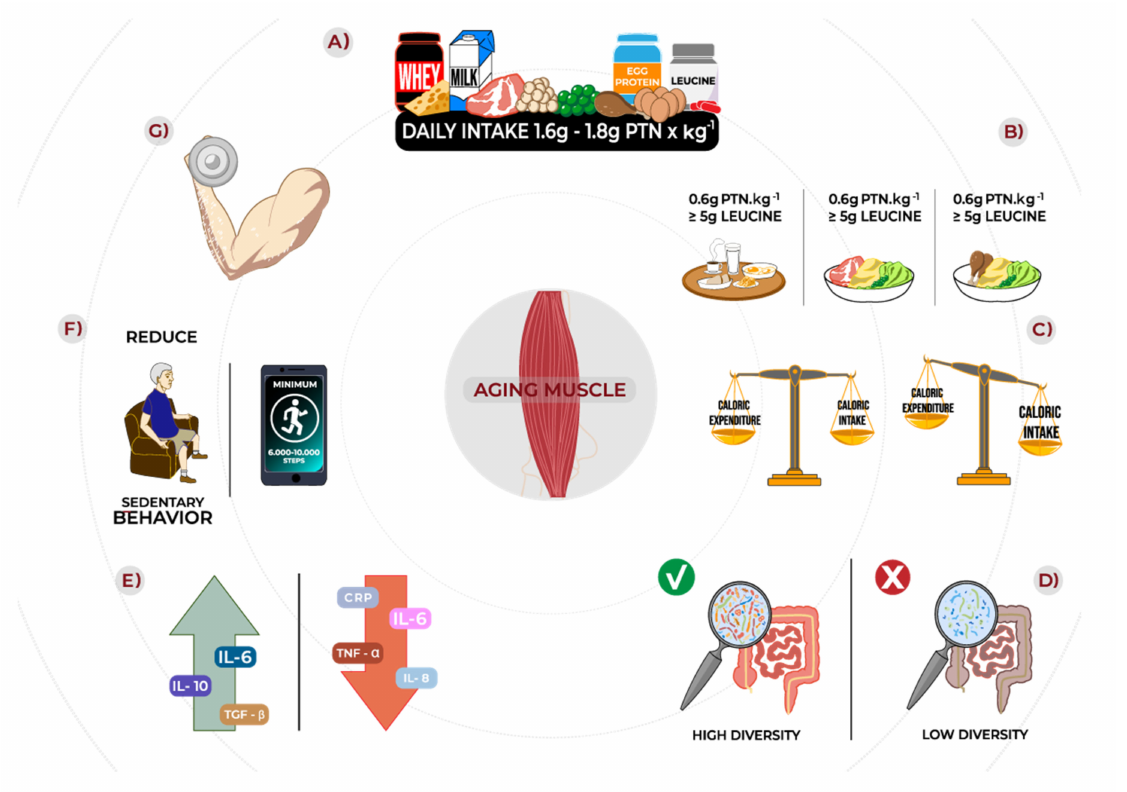
Figure 1. Maintenance of skeletal muscle health in aging. ( A ) Daily protein consumption of 1.6– 1.8 g · kg − 1 body weight, prioritizing high biological value protein through food or supplements. ( B ) Consumption of three daily protein meals containing 0.6 g of PTN · kg − 1 or at least 5–6 g of leucine. ( C ) Positive or neutral daily energy balance. ( D ) Maintenance of intestinal diversity. ( E ) Reduced or controlled pro-inflammatory state-higher concentration of anti-inflammatory markers (muscular IL-6, IL-10, and TGF— β ) compared to pro-inflammatory factors (adipocyte IL-6, IL-8, CRP, and TNF α ). ( F ) Reduced sedentary behavior ( ≤ 6 h · day − 1 ) or 6000–10,000 steps daily. ( G ) Resistance training